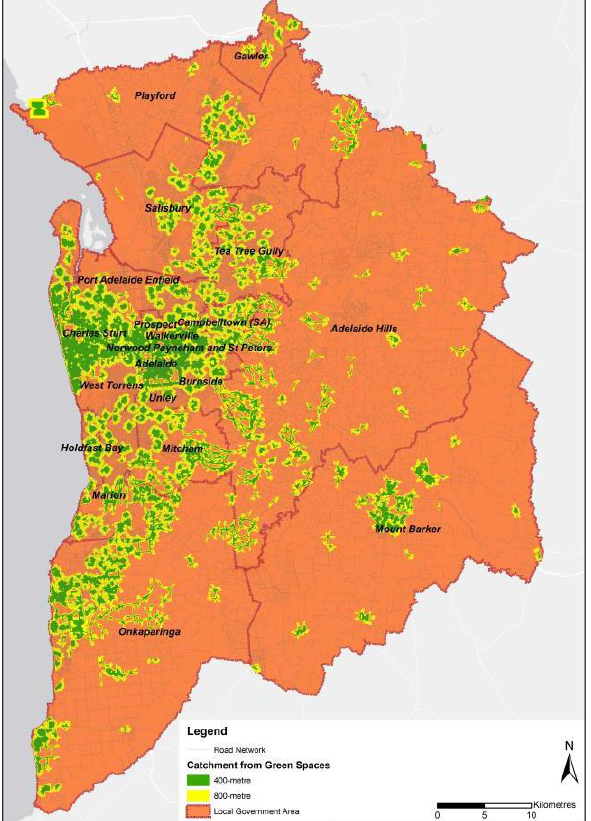
Figure 5. Mesh Blocks within the 400M and 800M catchment from UGSs in the Adelaide Metropolitan